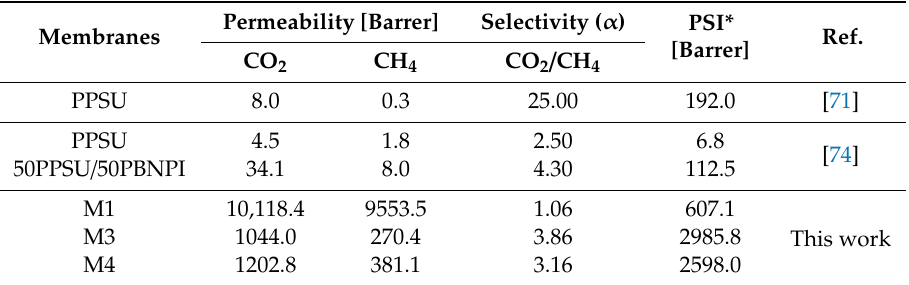
Table 5. The comparison of gas separation performances of PPSU based membranes. Permeability [Barrer] Membranes